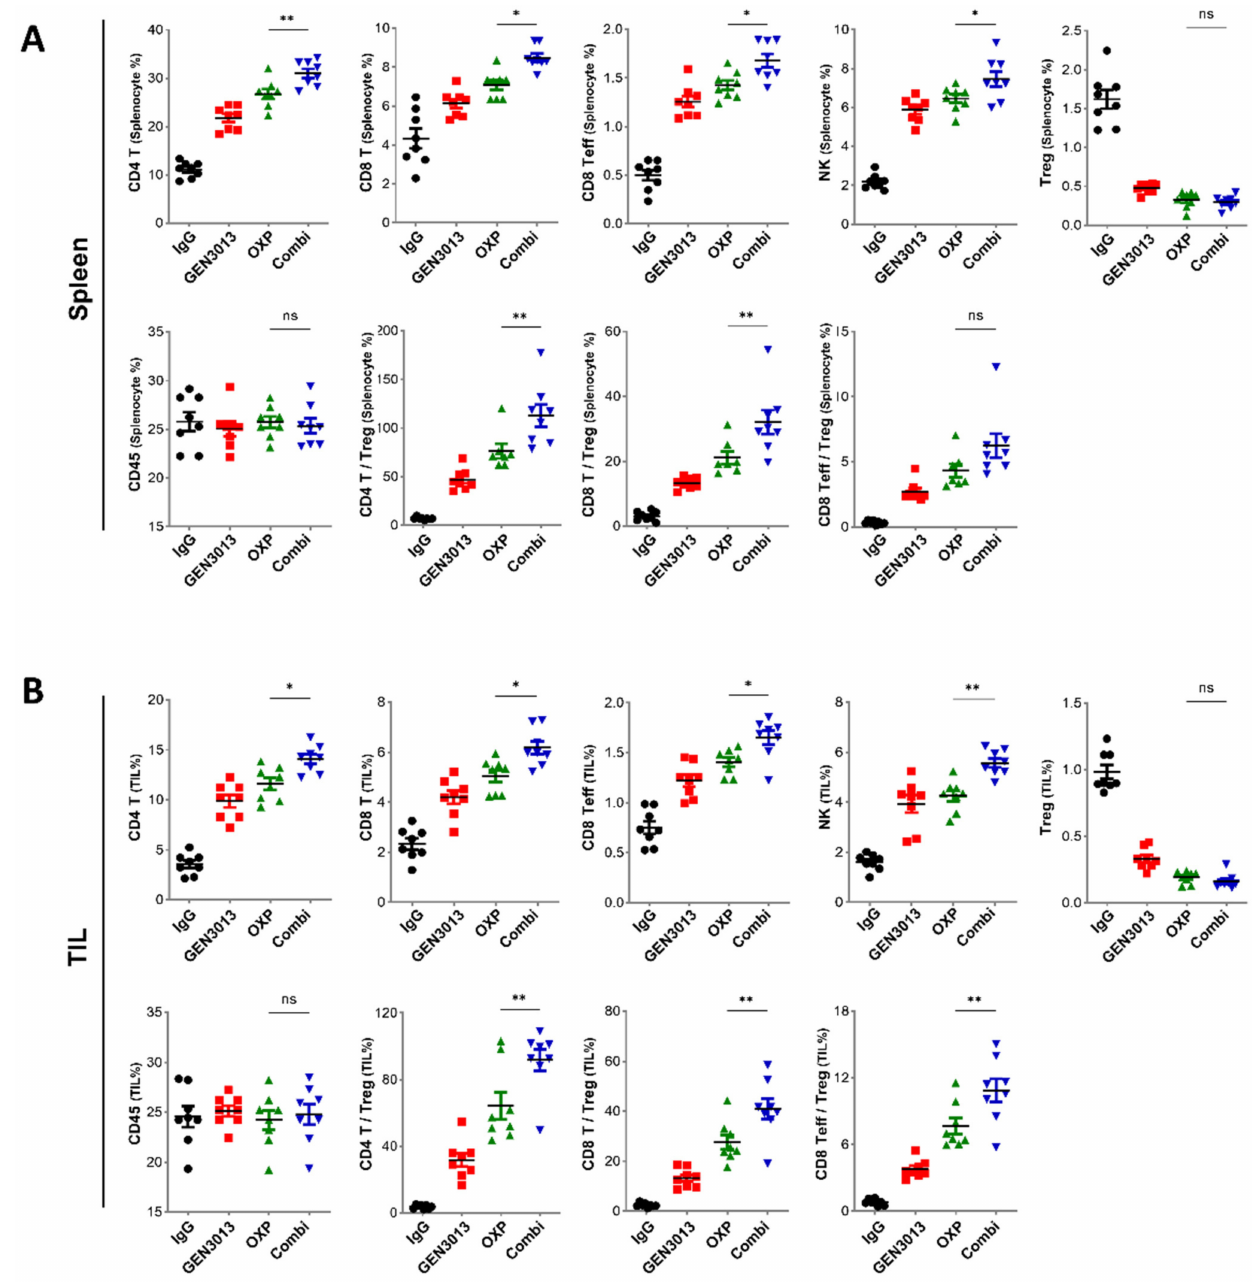
Figure 4. Combination of Lactococcus lactis GEN3013 and chemotherapy reprograms the host immune system. ( A , B ) Changes in the immune cell population of the spleen ( A ) or the tumor microenviron- ment ( B ) were measured via immune cell profiling after the administration of L. lactis GEN3013, oxaliplatin, or their combination (N = 8 per each group). Oxaliplatin versus combination in the spleen tissues: CD4 + T cells, p = 0.0075; CD8 + T cells, p = 0.0238; effector CD8 + T cells, p = 0.0213; NK cells, p = 0.0455; Tregs, ns; CD45 + cells, ns; CD4 + T cells/Tregs ratio, p = 0.007; CD8 + T cells/Tregs ratio, p = 0.0069; effector CD8 + T cells/Tregs ratio, ns. Oxaliplatin versus combination in the tumor tissues: CD4 + T cells, p = 0.012; CD8 + T cells, p = 0.0155; effector CD8 + T cells, p = 0.0386; NK cells, p = 0.0022; Tregs, ns; CD45 + cells, ns; CD4 + T cells/Tregs ratio, p = 0.0087; CD8 + T cells/Tregs ratio, p = 0.0058; effector CD8 + T cells/Tregs ratio, p = 0.0085. For all graphs, data are shown as the mean ± SEM and p -values are represented as * p ≤ 0.05, ** p ≤ 0.01, and ns (not significant). The statistical significance was determined using one-way ANOVA and Tukey’s test for multiple